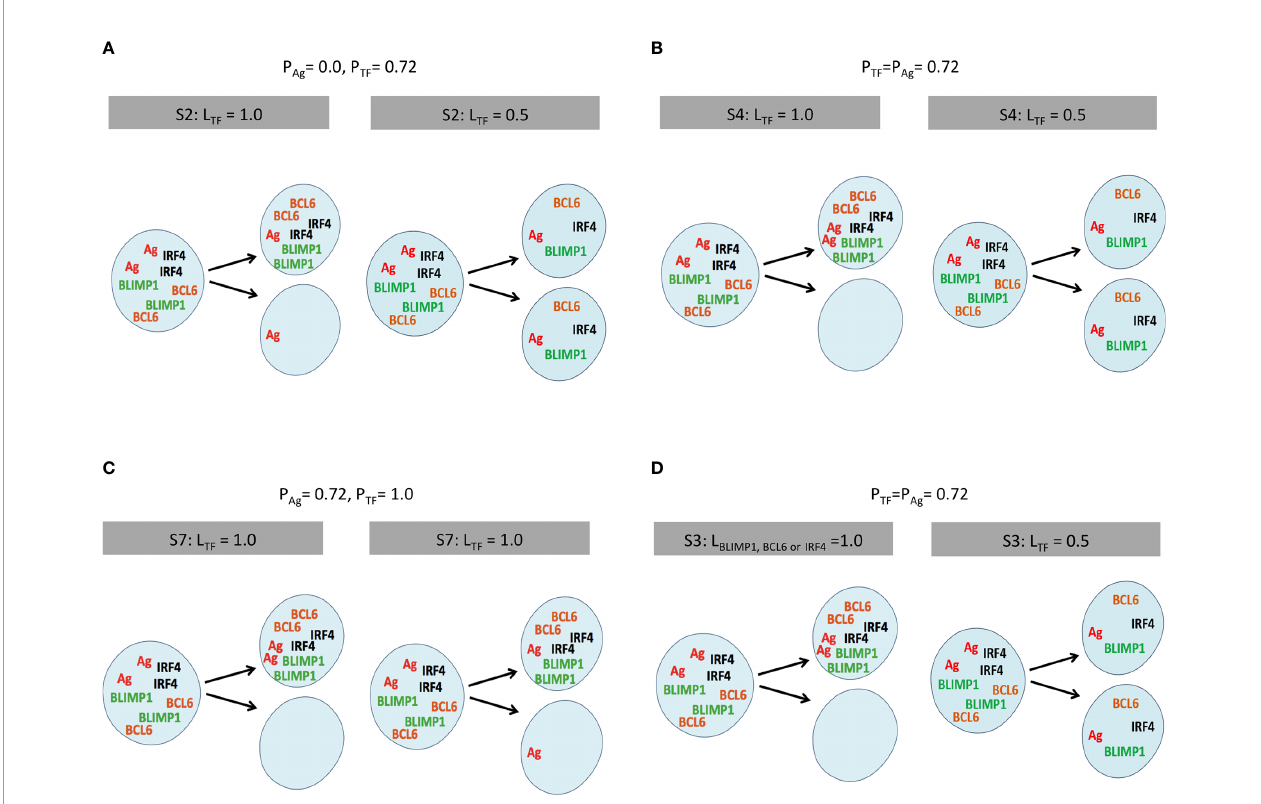
FIGURE 2 | Scheme of internalized Ag and TF division patterns modeled in a selection of simulations ( Tables 2 , 3 ). (A) Simulation 2, symmetric Ag and asymmetric TF distribution (L TF = 1.0). (B) Simulation 4, coupled asymmetric division (L TF = 1.0). (C) Simulation 7, uncoupled asymmetric division (L TF = 1.0), and (D) simulation 3, partial asymmetric co-segregation of TFs and Ag (P TF = P Ag = 0.72; L Ag = 1.0) while varying the level of BLIMP1 (L BLIMP1 = 1.0). Internalized Ag (red) and TF (orange, green, black) are shown in the parent and two daughter cells. The probability and polarity levels are shown in the gray